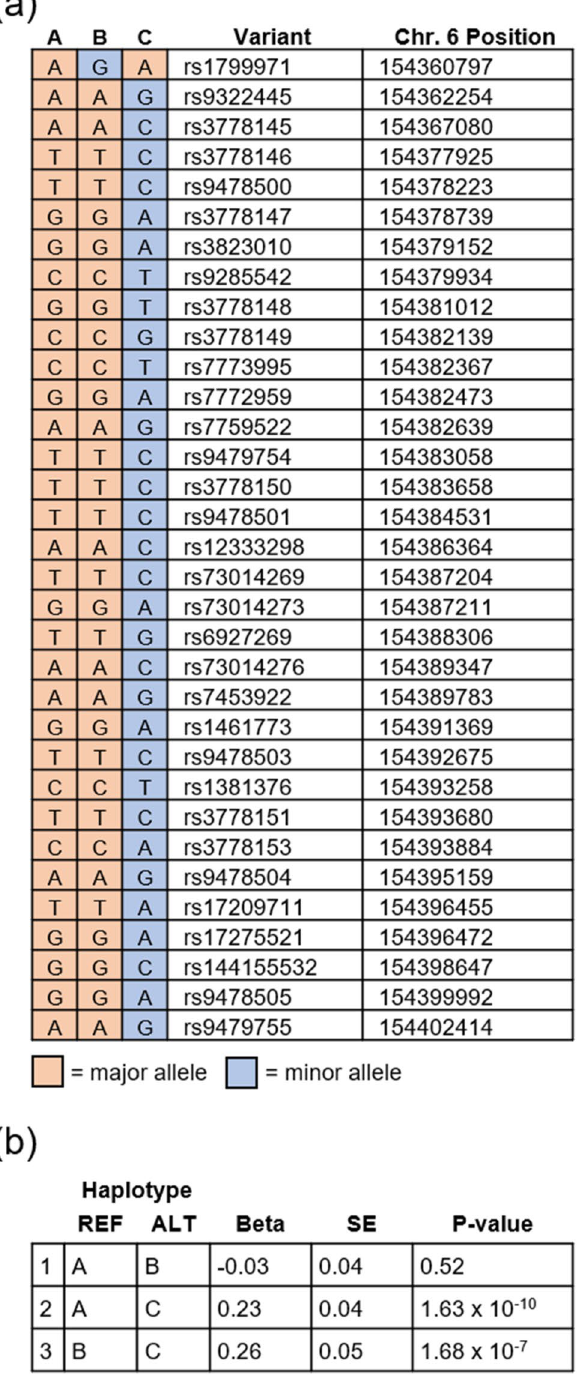
Figure 2. Association of major haplotypes for genome-wide significant OPRM1 variants with OA. ( a ) The 3 major haplotypes for genome-wide significant OPRM1 variants. Haplotype A is the predominant haplotype (frequency ~ 0.69 among contributing cohorts) and consists of major alleles for all variants. Haplotype B (frequency ~ 0.13 among contributing cohorts) consists of the minor allele for rs1799971 and the major allele for all other variants. Haplotype C (frequency ~ 0.16 among contributing cohorts) consists of the major allele for rs1799971 and minor allele for all other variants. The cohorts for whom we had the raw data to conduct the haplotype analyses were: UHS, VIDUS, ODB, Yale-Penn, CATS and Kreek (Supplementary Table 1). ( b ) Association of OPRM1 haplotypes with OA. Haplotype C is associated with increased risk of OA when compared to Haplotype A or Haplotype B, whereas Haplotype B does not have a significant impact on OA relative to Haplotype A. The single variant results using the cohorts contributing to the haplotype analyses were: rs1799971 beta = -– 0.058, p = 0.135; rs9478500 beta = 0.205, p = 2.43 × 10 –9